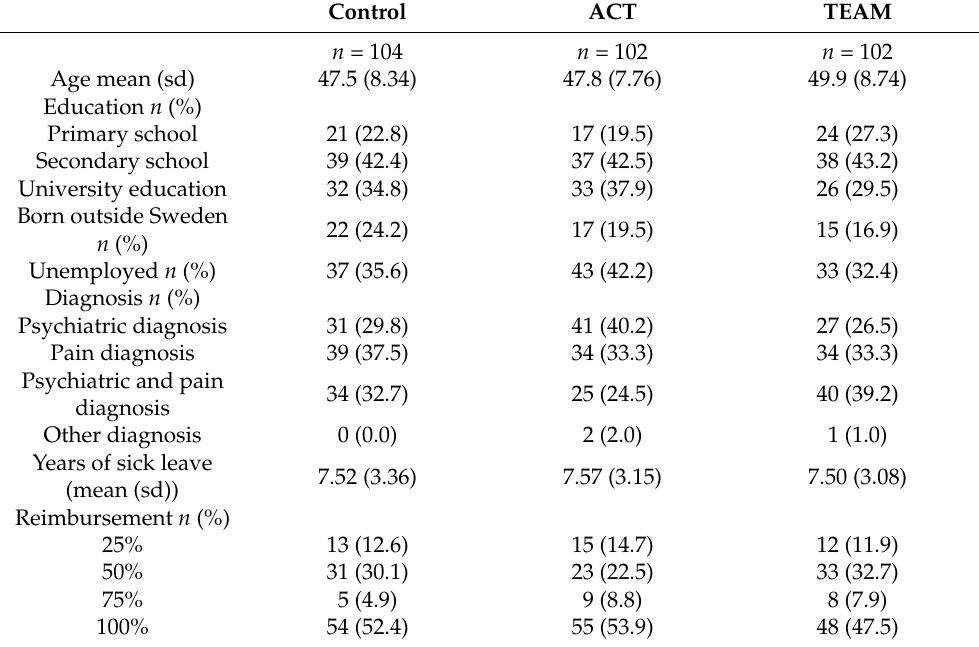
Table 1. Baseline characteristics of the